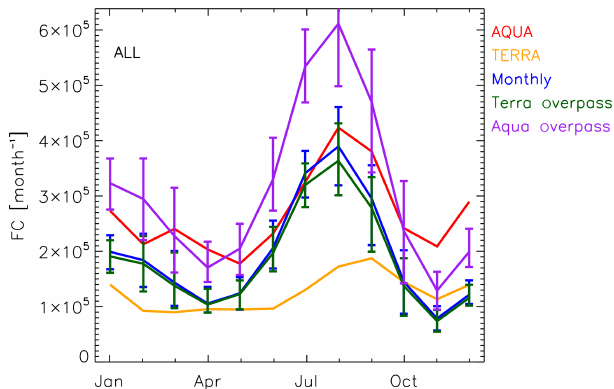
Figure 6. Global seasonality of total active fires (FC) by MODIS Aqua (red) and Terra (orange) and simulated by the model: monthly mean (blue), monthly mean sampled at the daytime Terra overpass time (green), and sampled at the daytime Aqua overpass time (pur- ple). Error bars represent the 10-year range in the